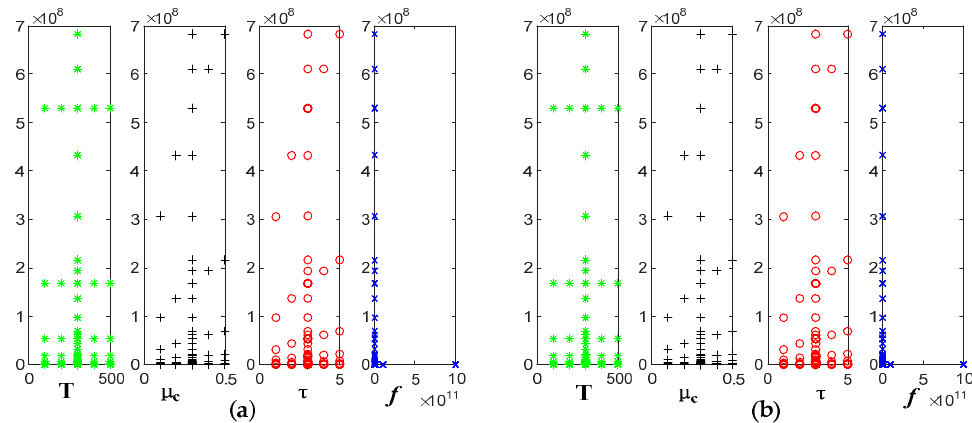
Figure 15. Linear correlation between T, μ c , τ , f and refractive index ( a ) Real part; ( b ) Imaginary part.